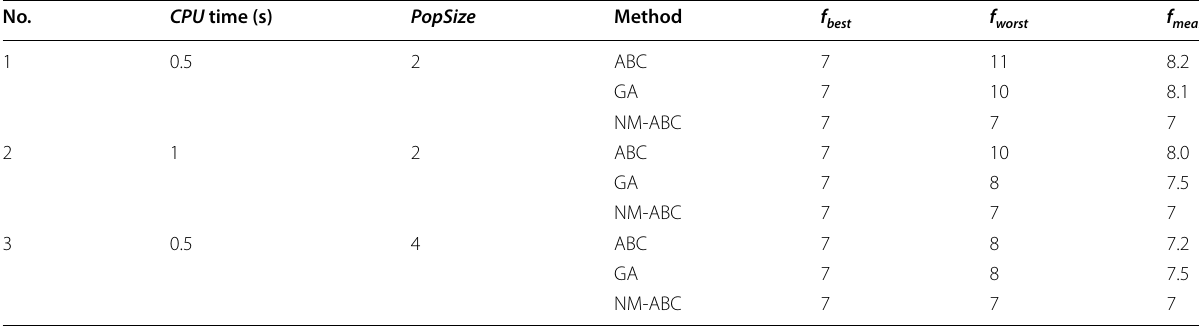
Table 7 Result comparison of the three algorithms for case study 1 No.